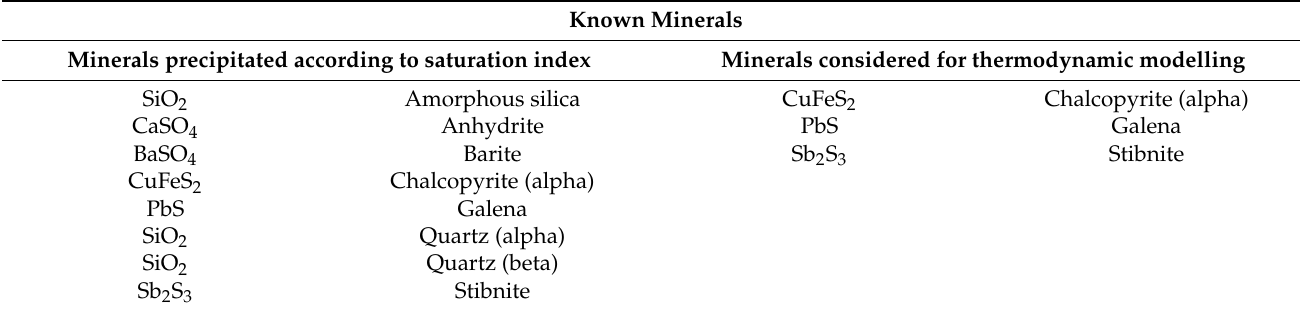
Table 10. Mineral precipitated for thermodynamic modelling (For 40–200 ◦ C). Known